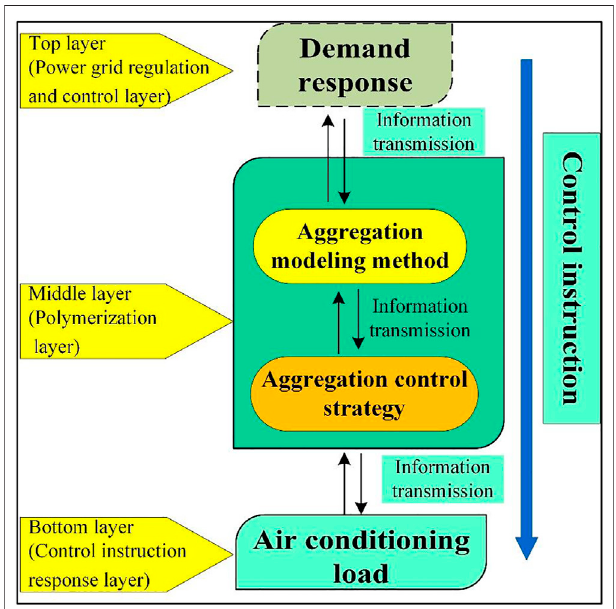
FIGURE 3 | Air conditioning load aggregation layered control